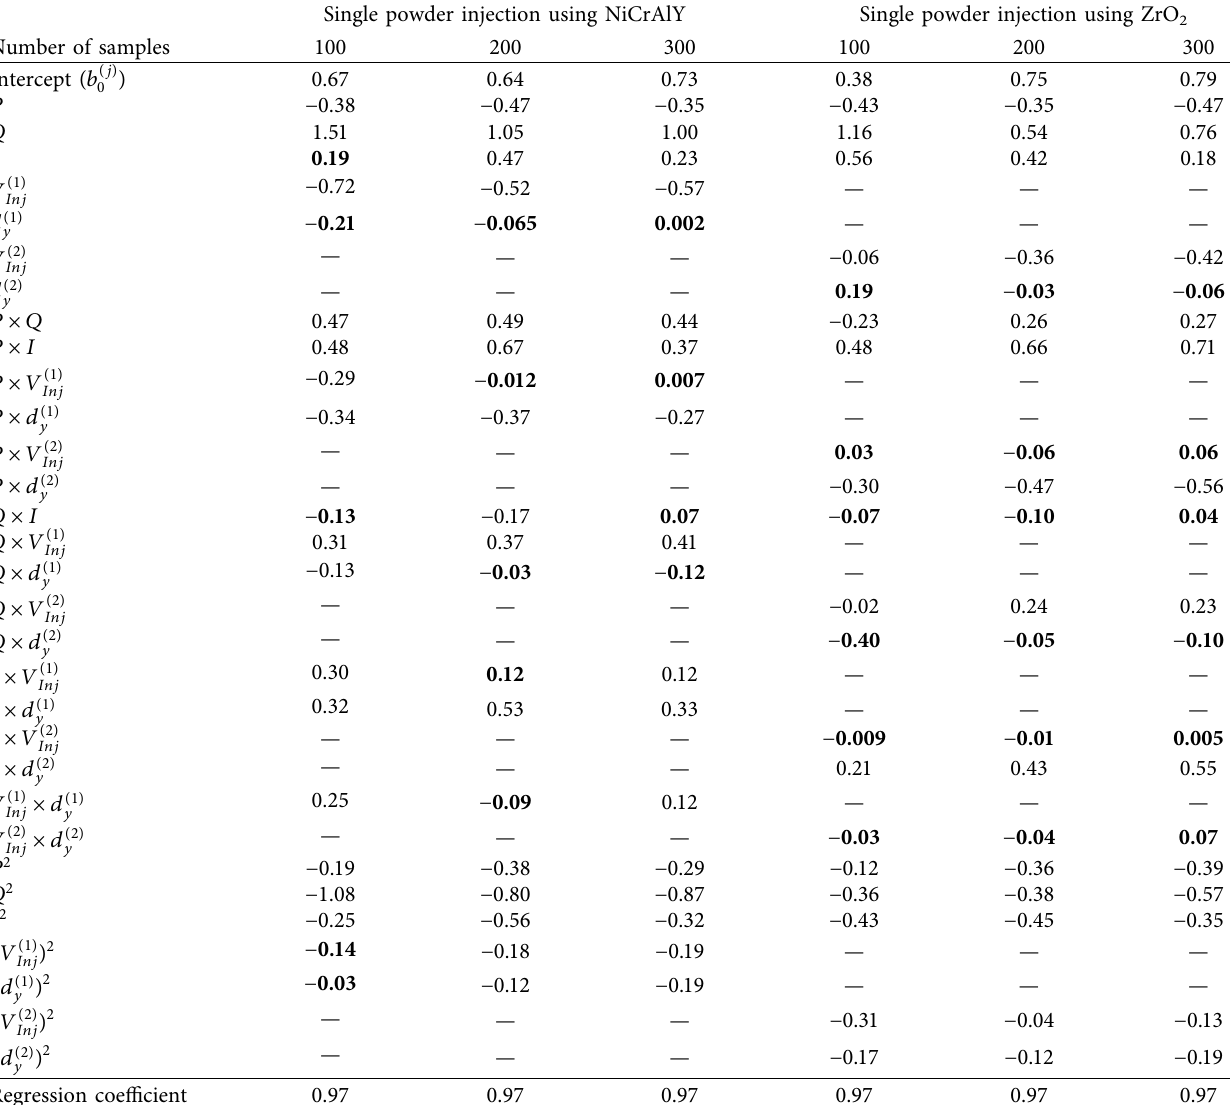
Table 3: Values of the coefcients of the response functions for the mean temperature in equation (21). Here, “—” means the corresponding variable does not appear in the response